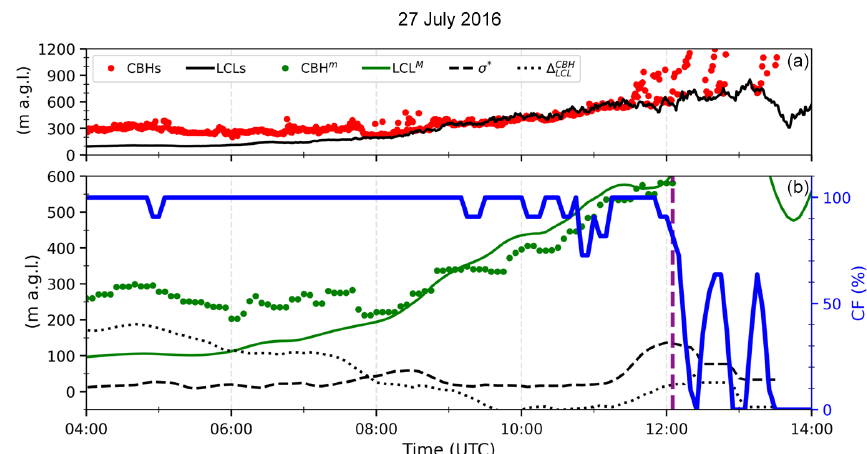
Figure 2. Time series of 1min ceilometer-derived CBHs and surface-based lifting condensation level (LCL) (a) and derived 5min diagnos- tics (b) : minimum of CBHs (CBH m ), mean LCLs (LCL M , solid green line), standard deviation of the difference between CBHs and CBH m ( σ ∗ , dashed black line), the difference between CBH m and LCL M ( (cid:49) CBH , dotted black line) and cloud coverage fraction (CF, solid blue LCL line) between 04:00 and 14:00UTC on 27 July 2016. The vertical dashed purple line marks the breakup time of the LLSC layer ( T b ). The local time at Savè (in Benin) is UTC +